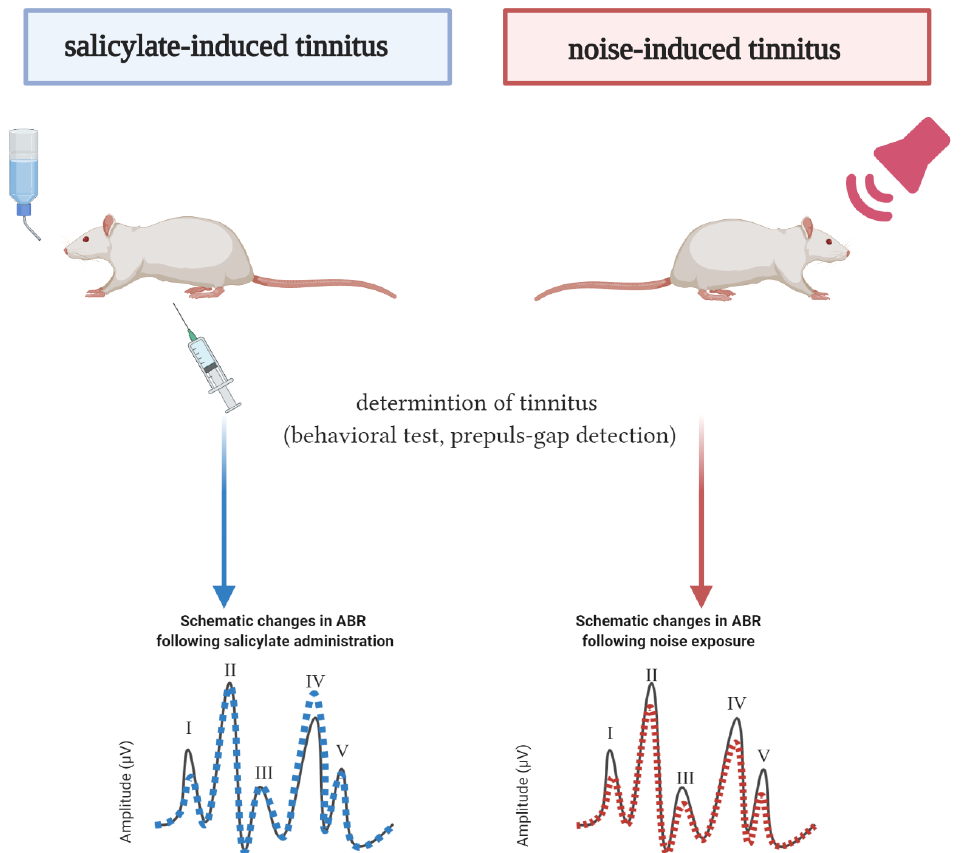
Figure 4. Schematic representation of the ABR profile’s similarities and differences between the control rats and animals with tinnitus (created with BioRender.com). Of 36 publications included in this review, four publications regarding noise-induced tinnitus and six publications regarding salicylate-induced tinnitus qualified for the quantitative ABR analyses. The solid black line represents the ABR of the control animals. The dashed blue line represents the ABR of rats with salicylate-induced tinnitus [27,28,49,53,58,59]. The red dashed line represents the ABR of rats with noise-induced tinnitus [15,65]. Only the changes consistently reported by two or more studies were taken into account. The changes in latencies are not presented due to inconsistencies between the studies.